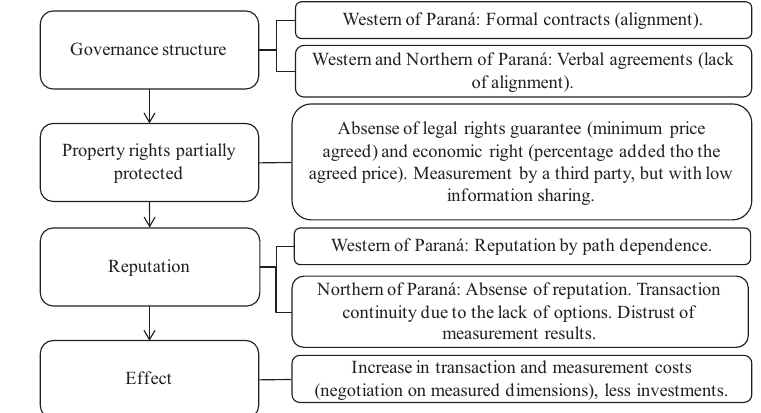
Figure 3. Results in cases of limited